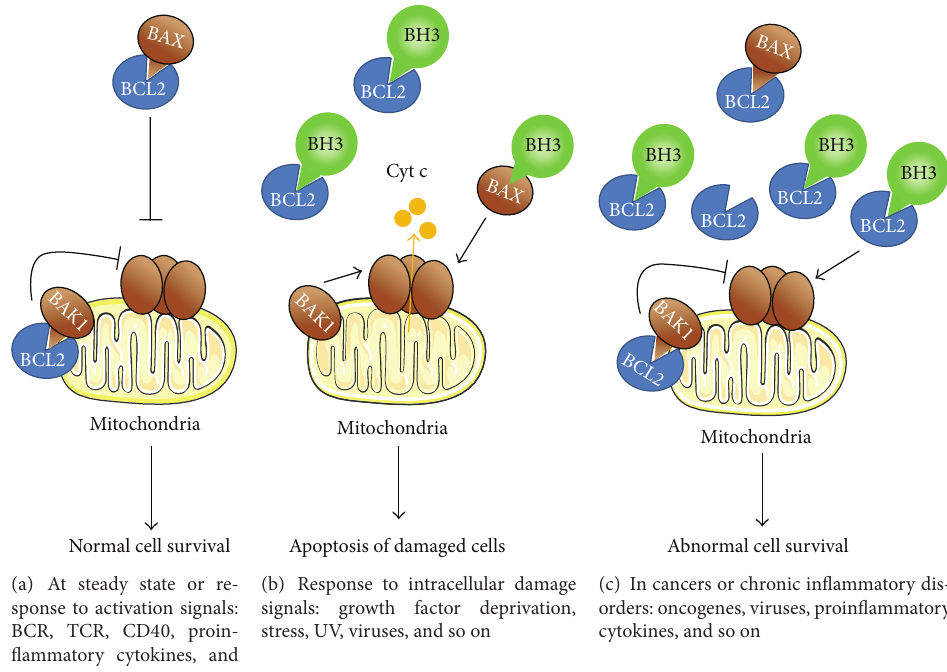
Figure 3: Model of survival control by the BCL2 family in physiological and inflammatory conditions. (a) In a physiological context or following an immune response, constitutive or inducible prosurvival proteins (here BCL2) bind multidomain proapoptotic proteins (BAX, BAK) that become unable to oligomerize, thereby resulting in normal cell survival at steady or activated state. (b) In response to intracellular damage, activator BH3-only proteins are induced or activated. They inhibit the prosurvival proteins and activate the effector multidomain proapoptotic proteins, which in turn are homooligomerize, triggering cytochrome c release (Cyt c) and apoptosis. Potentially abnormal cells are then eliminated. (c) In a pathological context, such as cancers and chronic inflammatory diseases, prosurvival proteins are upregulated, inhibiting the multidomain and BH3-only proapoptotic proteins. As a result, the membrane of mitochondria remains intact and abnormal cells